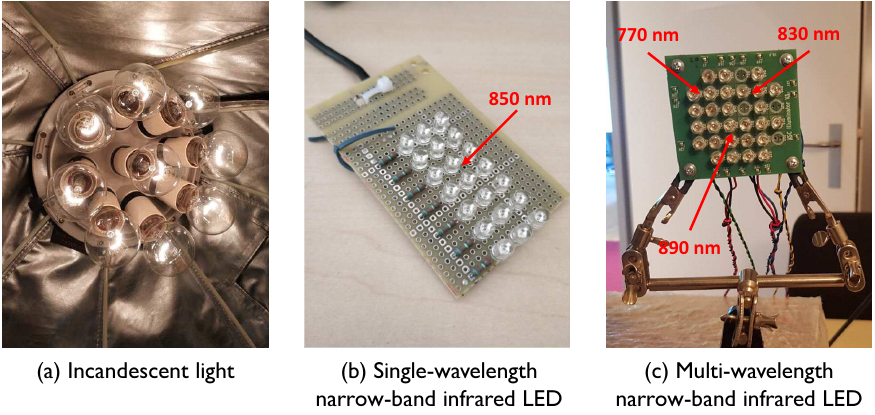
Figure 1. Different light sources that could be considered as the illumination unit of an infrared remote-PPG